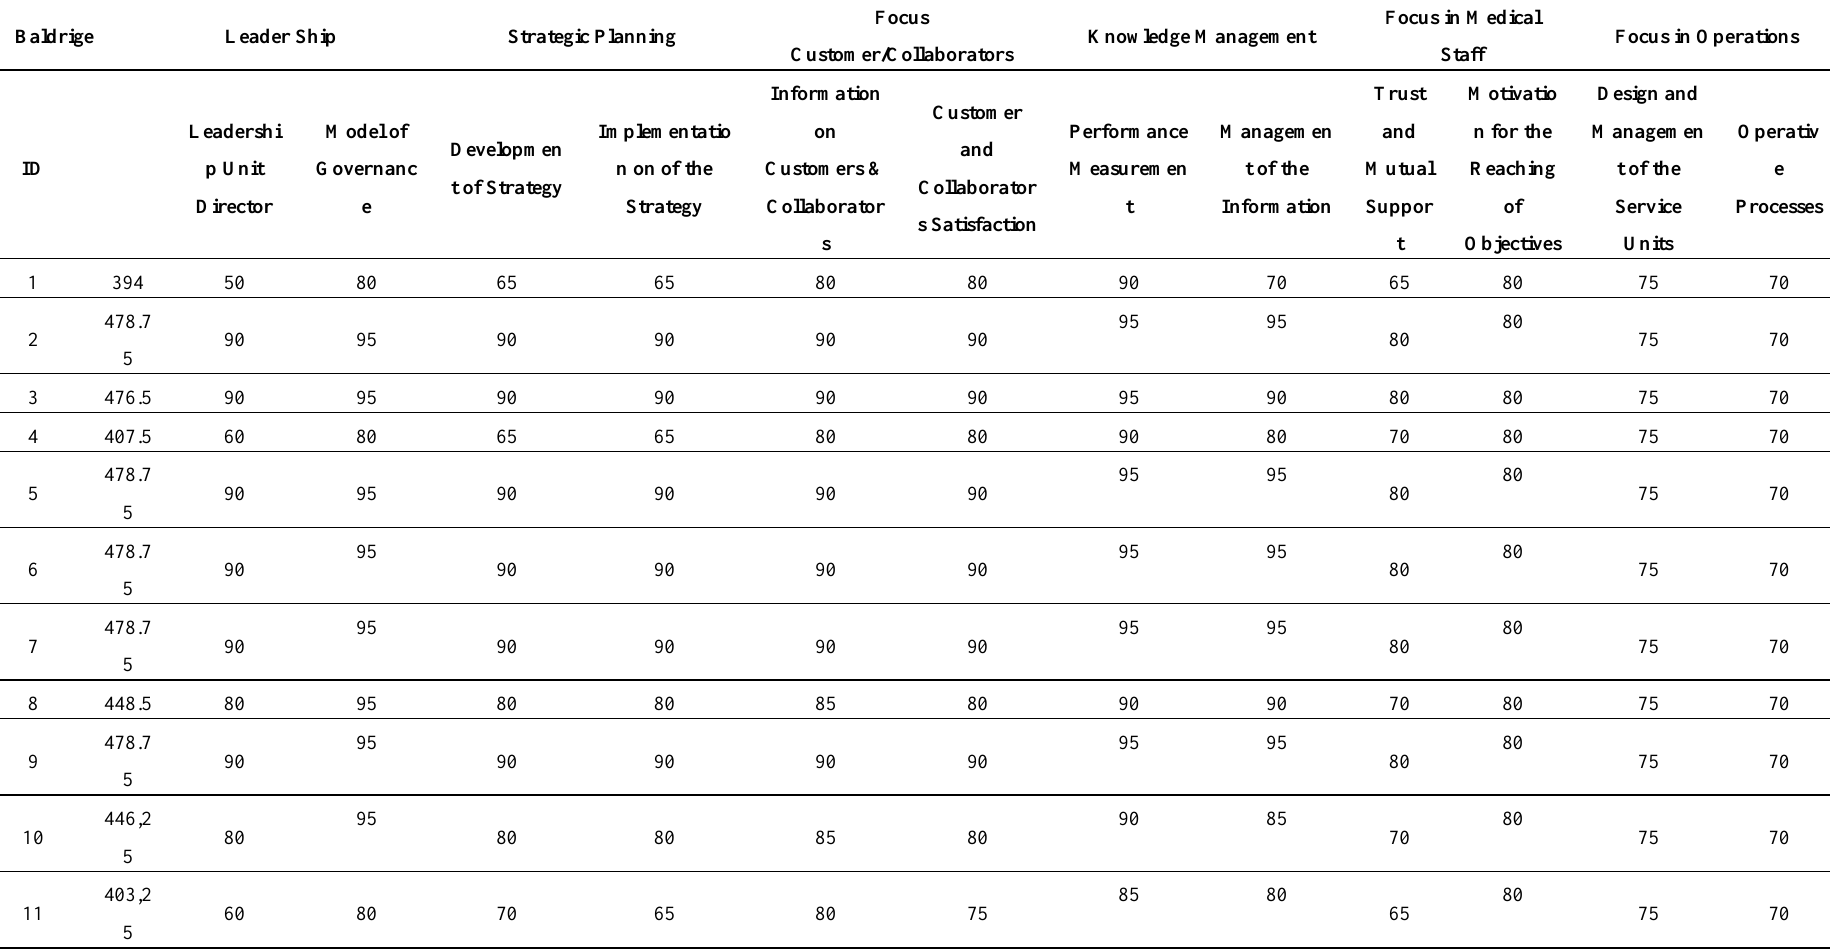
Table 4. Levels of quality achieved in each hospital according to the Baldrige